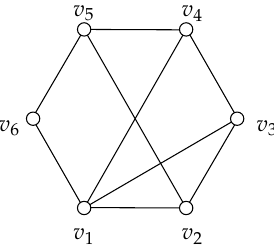
Figure 1. The chord distance of this C 6 graph is two because: (i) vertices v 1 and v 2 are consecutive in the cycle, (ii) every chord is incident to one of such vertices, and (iii) there is no other set with less than two vertices with the same properties.